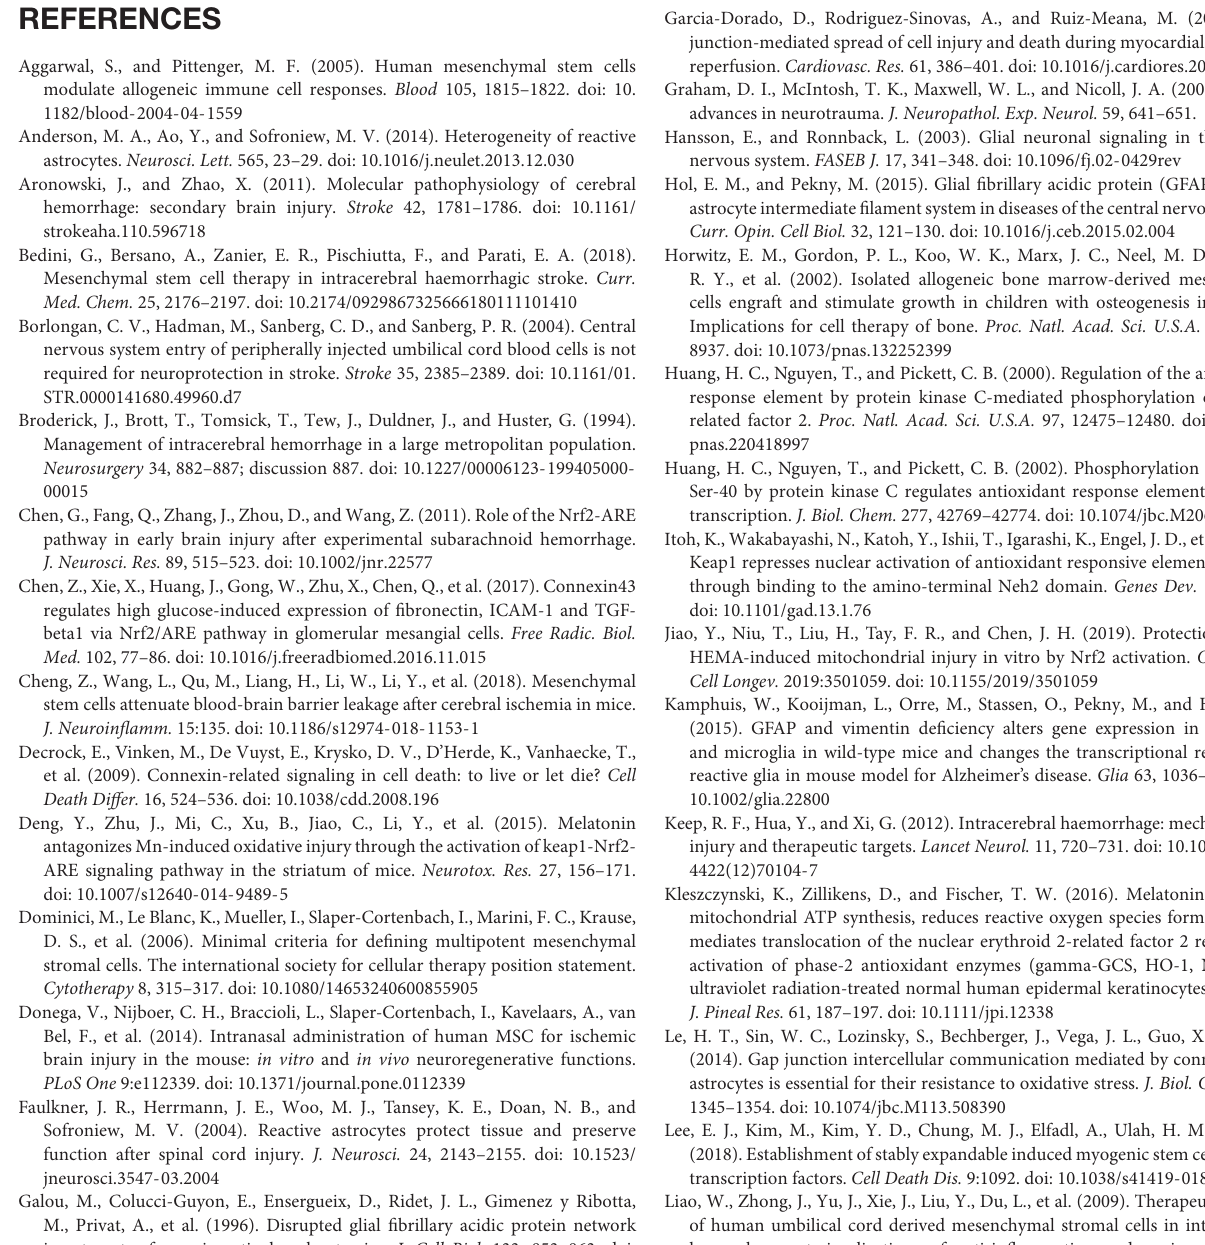
FIGURE S2 | The diagram and results of luciferase activity analysis between Nrf2 and HO-1 in primary astrocytes. (a) The HO-1 wildtype group (WT) and the HO-1 mutation group (Mut) were set up to verify our experiments. Three mutation sites were set at – 303 ∼ – 298 bp, – 138 ∼ – 133 bp, and – 2 ∼ 3 bp, respectively (from − 500 bp upstream to 100 bp downstream). (b) All data are displayed as means ± SD ( n = 4). The difference between groups was analyzed using One-way ANOVA test. * p < 0.05, *** p < 0.001, compared with control.